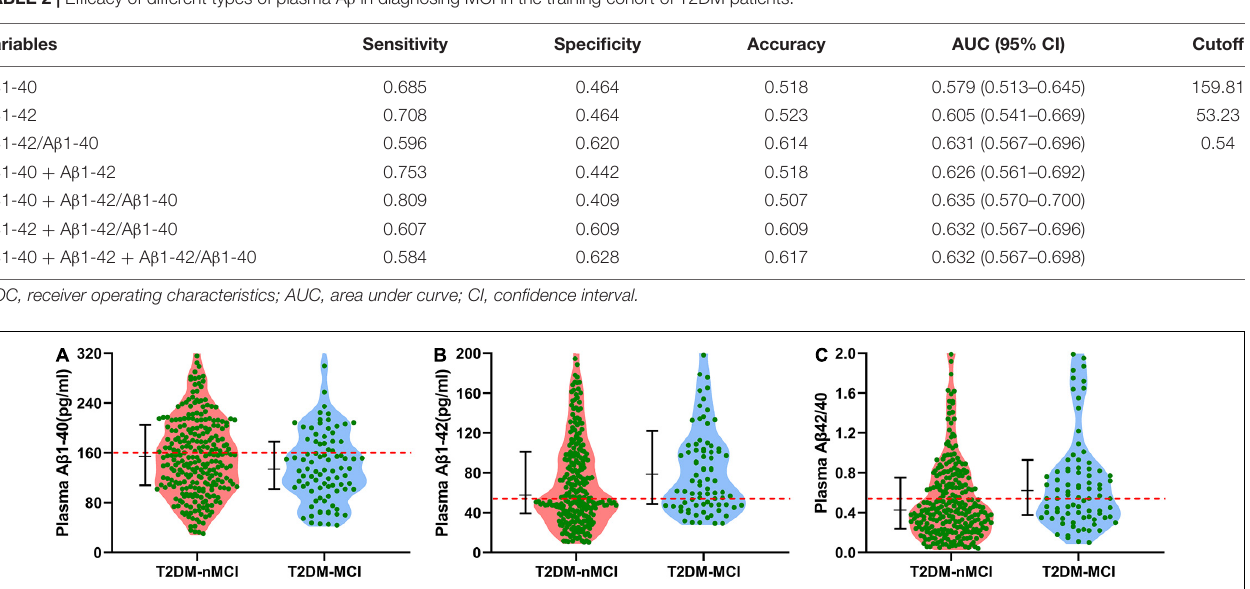
FIGURE 1 | Cutoff points of different types of plasma A β in discriminating T2DM-MCI from T2DM-nMCI in the training cohort. (A) By using A β 1-40, most of the population in T2DM-nMCI and T2DM-MCI groups was distributed under the cutoff point (159.81 pg/ml; red line). (B) By using A β 1-42, most of the population in T2DM-nMCI and T2DM-MCI groups was distributed above the cutoff point (53.23 pg/ml; red line). (C) By using A β 1-42/A β 1-40, the T2DM-MCI could be nicely discriminated from T2DM-nMCI patients at cutoff 0.54. Data were presented as median (interquartile range).